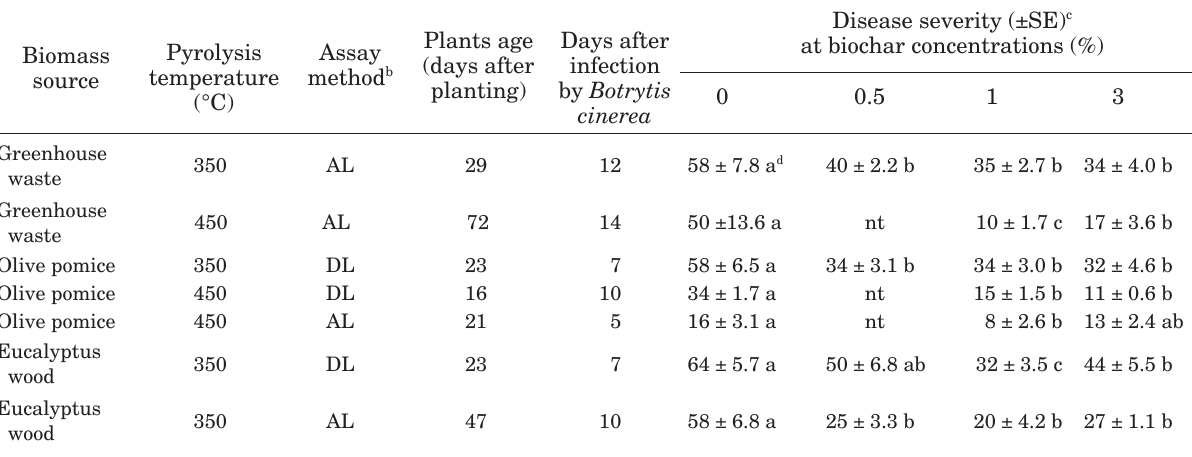
Table 1. Effect of adding biochars a produced from different feedstocks at HTTs of 350 and 450°C on the severity of tomato leaf grey